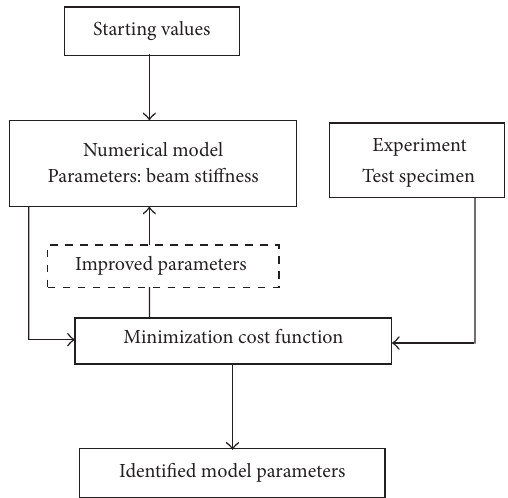
Figure 1: General flowchart of a FEM